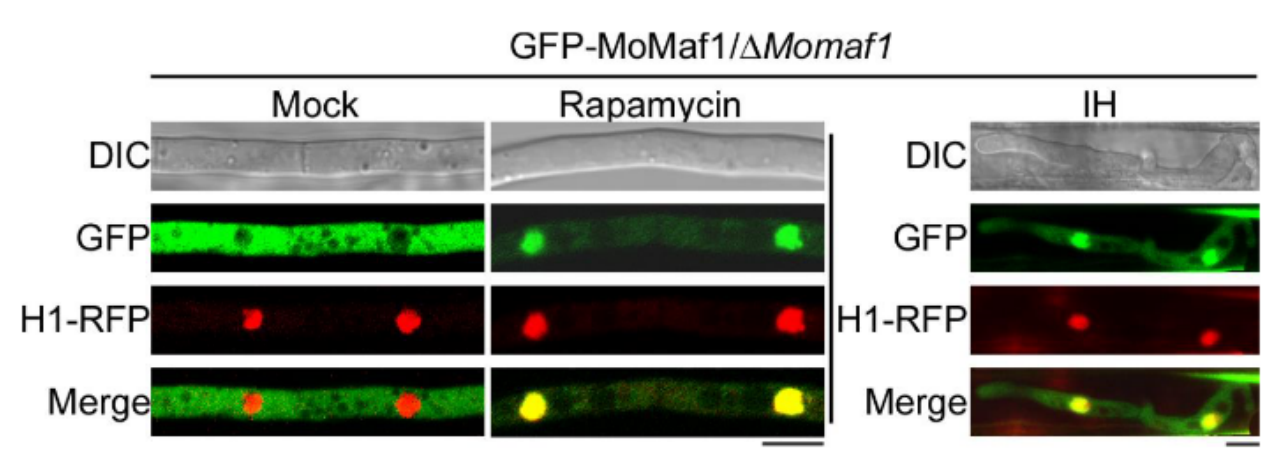
Figure 6. Subcellular localization of GFP-MoMaf1 at different phases. The subcellular localization of GFP-MoMaf1 was observed using the complemented strain with or without rapamycin (30 ng/mL) treatment for 40 min, and nuclei were stained with DAPI ( left ). Scale bar, 10 µ m. Subcellular localization of GFP-MoMaf1 during the early infection phase ( right ). Scale bar, 5 µ m.